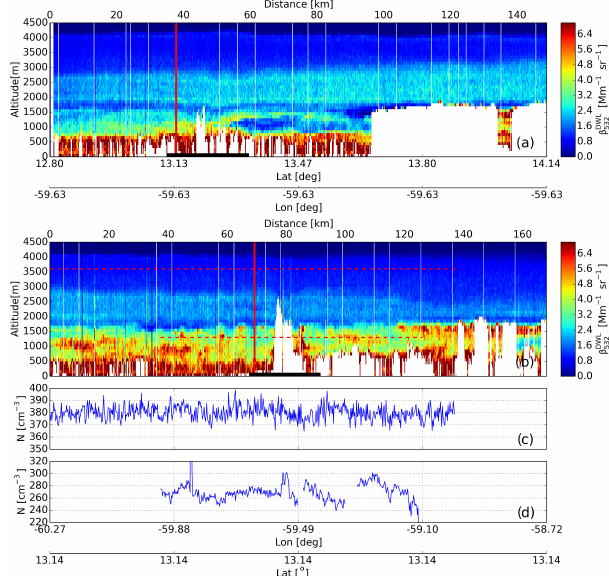
Figure 13. (a) Retrieved backscatter coefficient by the DWL as a function of the latitude and longitude from leg 1, together with the latitude at which legs 2, 3 and 4 were flown (solid line, red). (b) Re- trieved backscatter coefficient by the DWL as a function of the lati- tude and longitude from leg 2, the intersection position with the 1st leg (solid line, red) and the legs 3 and 4 are shown (dashed line., red). (c, d) In situ CPC measurements corresponding to the legs 3 and 4. The white colour indicates regions where no atmospheric signal is available (e.g., below clouds, unseeded laser operation). Barbados indicated in both plots with a horizontal solid black line.